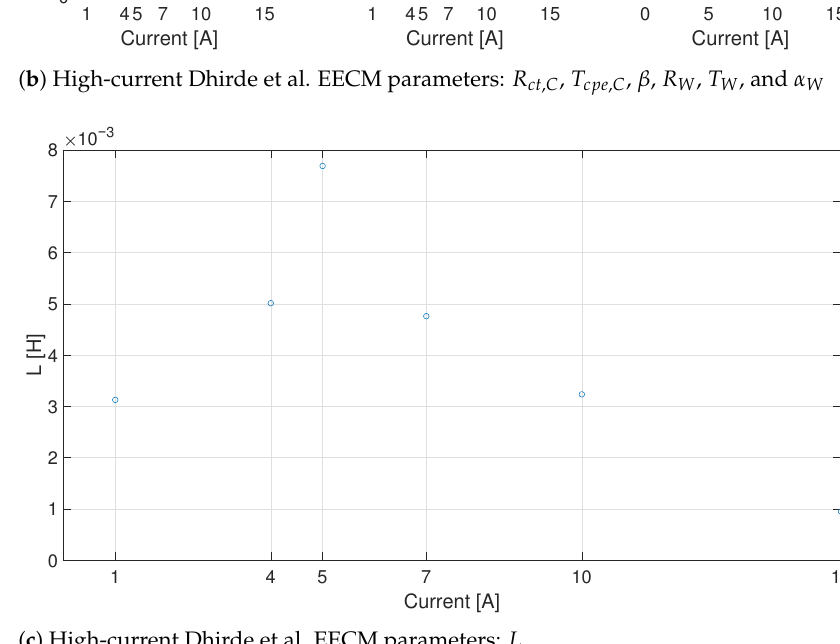
Figure 23. The high-Current Dhirde et al. EECM